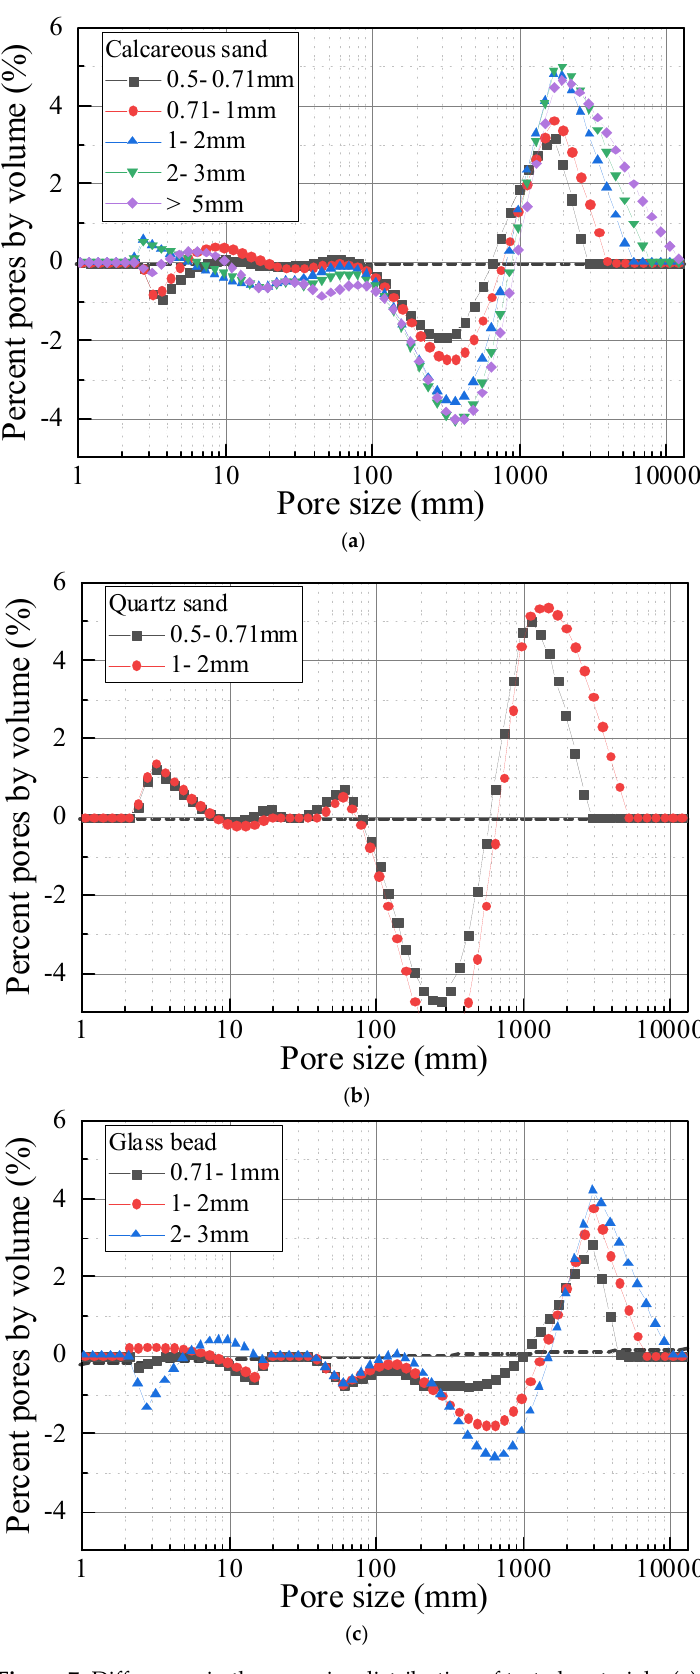
Figure 7. Differences in the pore size distribution of tested materials: ( a ) Calcareous sand; ( b ) Quartz sand; ( c ) Glass bead. 3.2. Effect of Grain Size on the Microsrcture’s Fractal Dimension Liang, et al. [44] reported that the lg S v -lg R curve of soil included two distinct parts and proposed that the PSD in soils showed multi-fractal characteristics. The lg S v -lg R curve of calcareous sand, quartz sand, and glass bead are shown in Figures 8–10, respectively. There is an obvious inflection point around the pore diameter of 10 um in the lg S v -lg R curve, indicating that the pore size of about 10 μ m is a limitation for the change of pore properties in the carbonate-based sand and silicate-based sand. The dominant pore struc- ture content of carbonate-based sand and silicate-based sand is distributed in the large- size range (i.e., the pore structure with a size greater than 10 μ m. Furthermore, the larger pore structure of sand assembly more tends to be a skeleton pore structure with strong